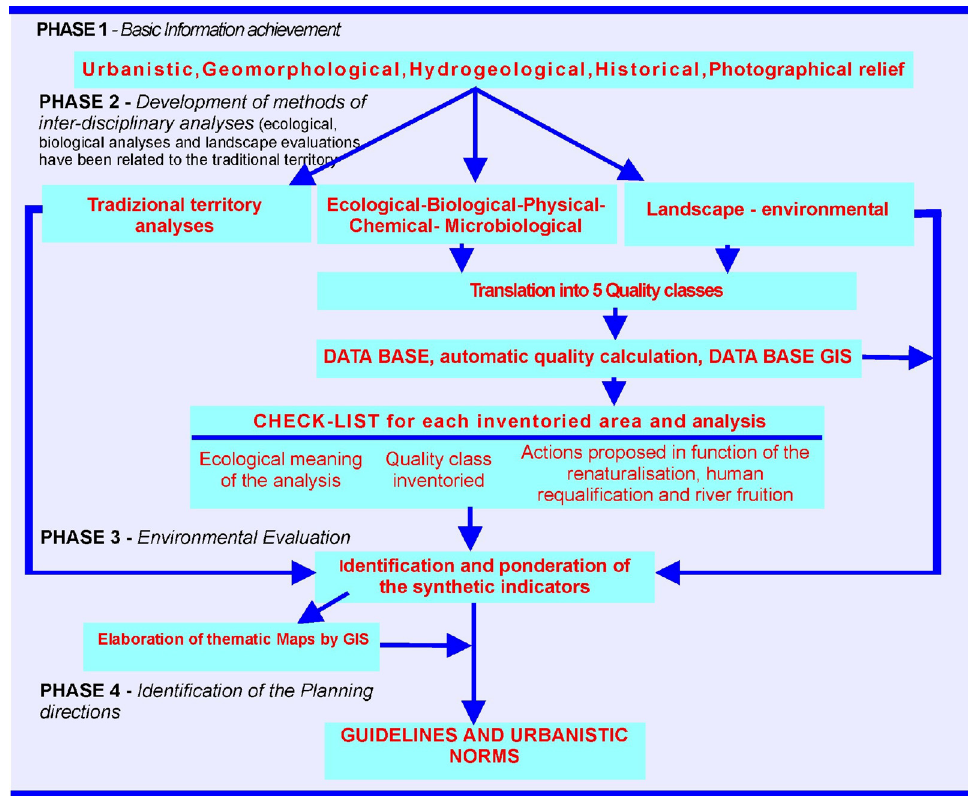
FIGURE 1. Scheme of the analysis and environmental evaluation (modified from